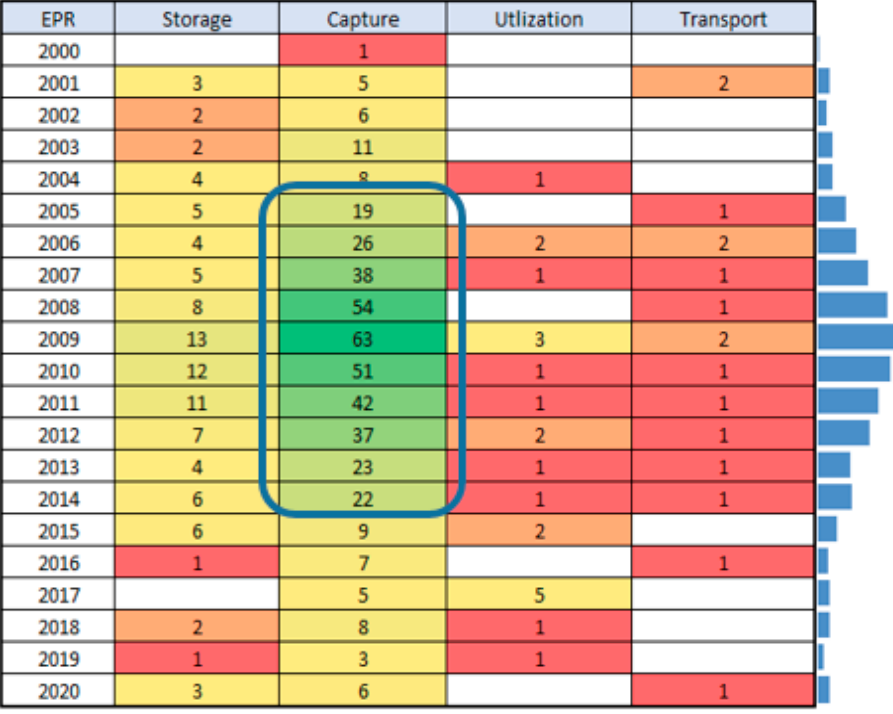
Figure 12. CCUS types—priority year (bar chart).